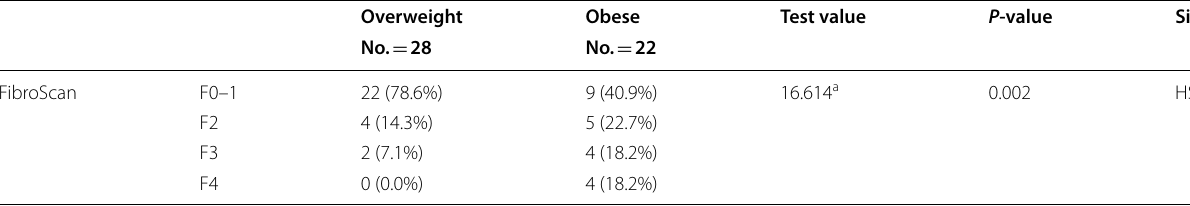
FibroScan grading for our participants, the exact distribution of grades F0–F4 among both groups P -value > 0.05, non-significant; P -value < 0.05, significant; P -value < 0.01, highly significant a